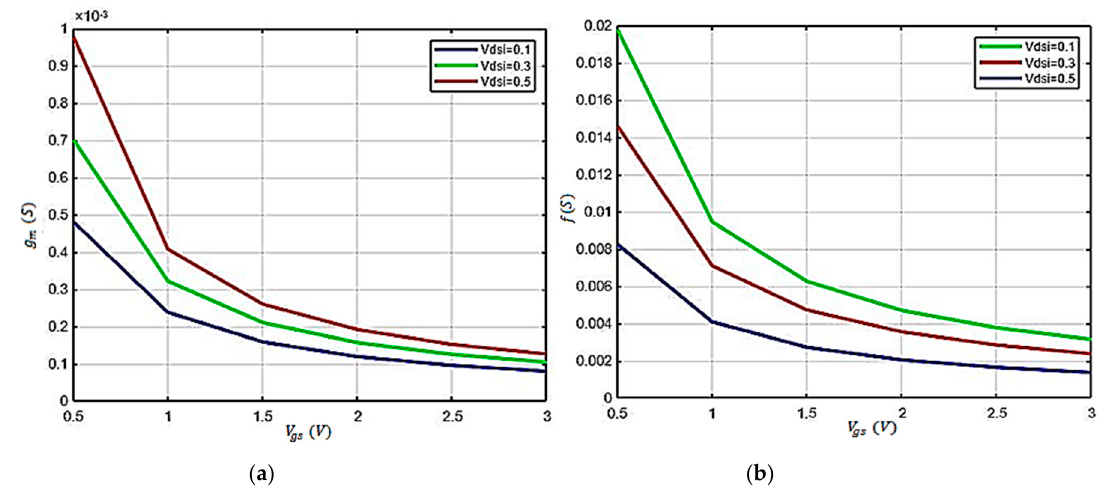
Figure 6. Graphical representation of the drain transconductance and transit frequency. ( a ) Transconductance as a function of gate voltage of graphene field effect transistor (GFET). ( b ) Transit frequency as a function of gate-to-source voltage.